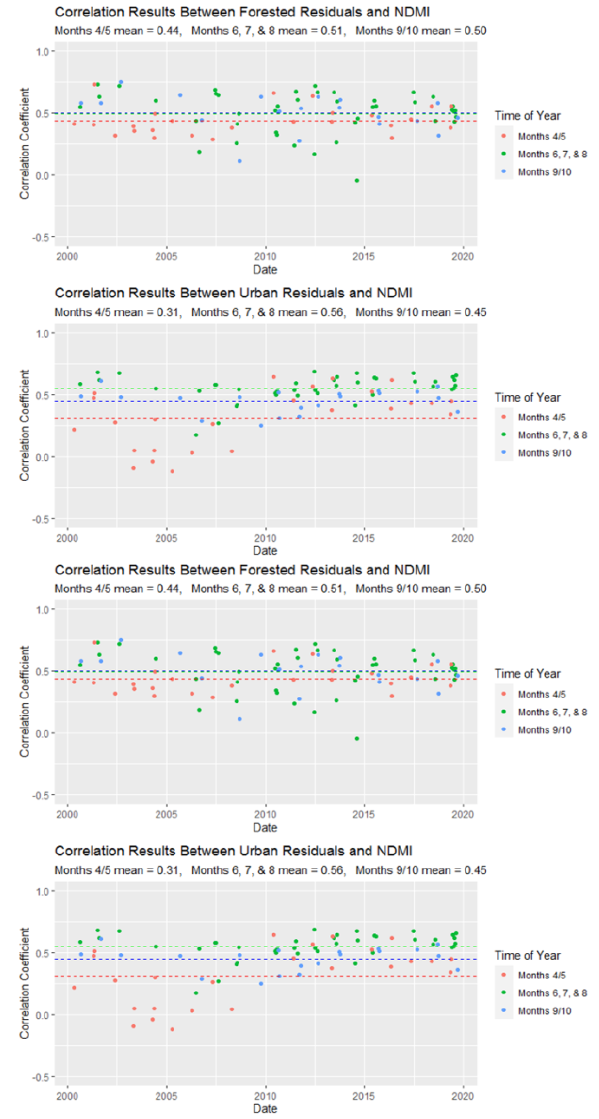
Figure 9 . The correlation coefficient each land cover’s residuals have with the NDMI product with the same Landsat 7 product.